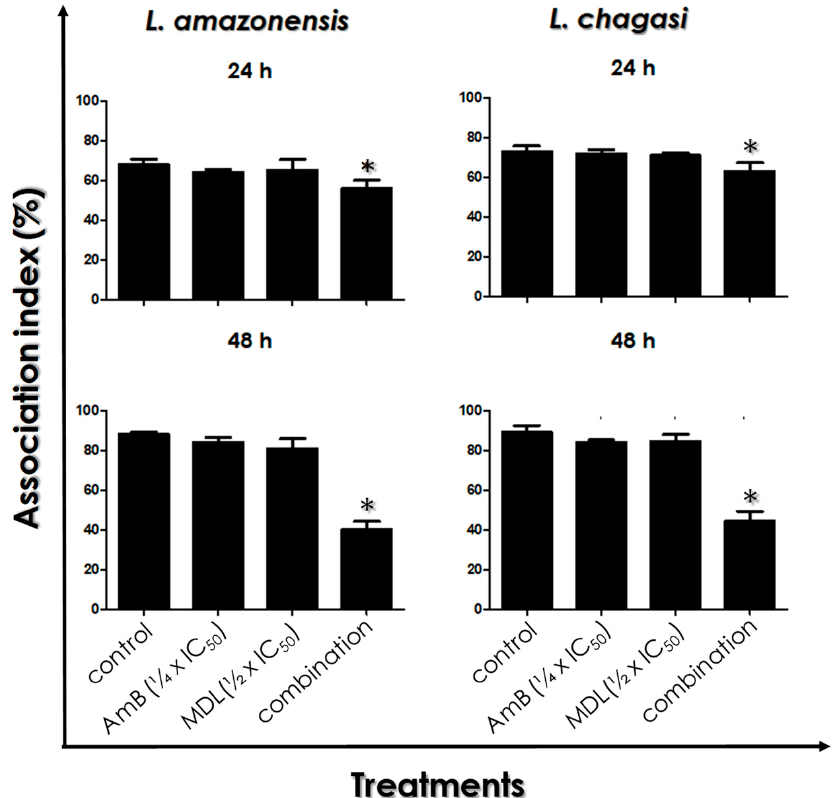
Figure 7. Susceptibility of L. amazonensis and L. chagasi intracellular amastigotes to the combination